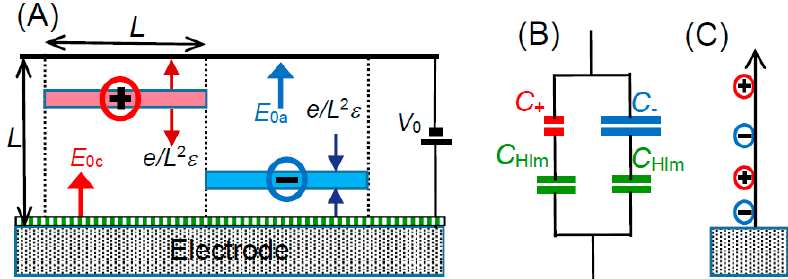
Figure 6. ( A ) Illustration of the model of ionic distributions caused by the applied voltage V 0 and the charge ± e , ( B ) the equivalent circuit for the four capacitances, and ( C ) predicted one-dimensional distribution of ions.